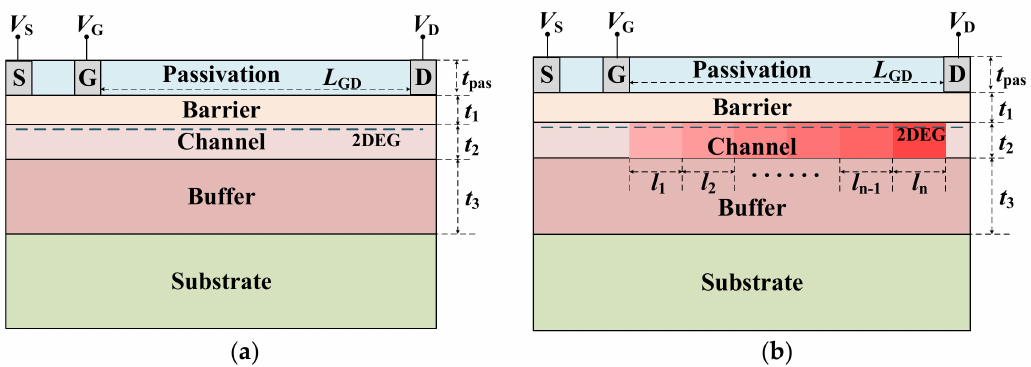
Figure 1. Schematic of the cross–section of ( a ) the conventional HEMT and ( b ) the n –step SDC–HEMT.